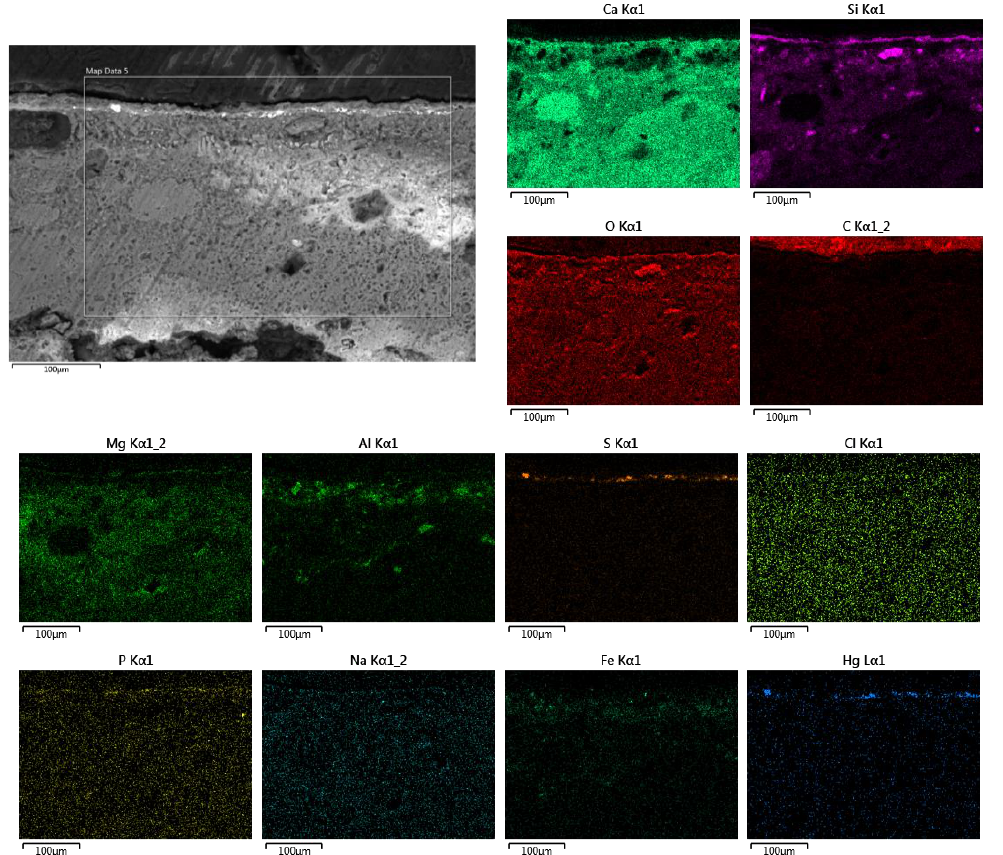
Figure 9. The pictorial layer in section through the fresco.